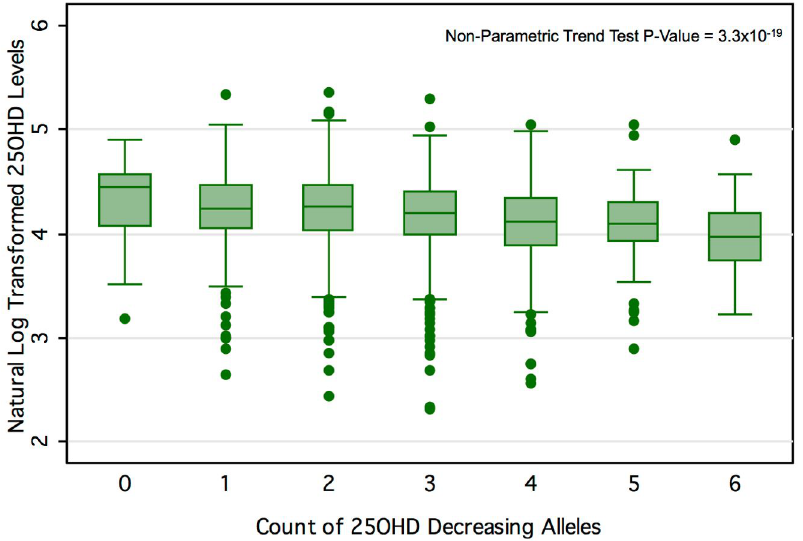
Fig 3. 25OHD level by number of 25OHD-decreasing alleles in the CaMos cohort. Here we show the box-plot of natural-log-transformed 25OHD by the count of 25OHD-decreasing alleles in the CaMos population. A count of zero represents individuals with no 25OHD-decreasing alleles (or homozygous at each loci for the 25OHD-increasing allele), and a count of six represents an individual with six 25OHD-decreasing alleles. No individuals with a count of seven or more 25OHD-decreasing alleles were observed in this cohort. The center line and error bars represent the mean level of natural-log-transformed 25OHD and its 95% CI for each respective allele count. Note a negative trend between allele count and mean natural-log-transformed 25OHD.